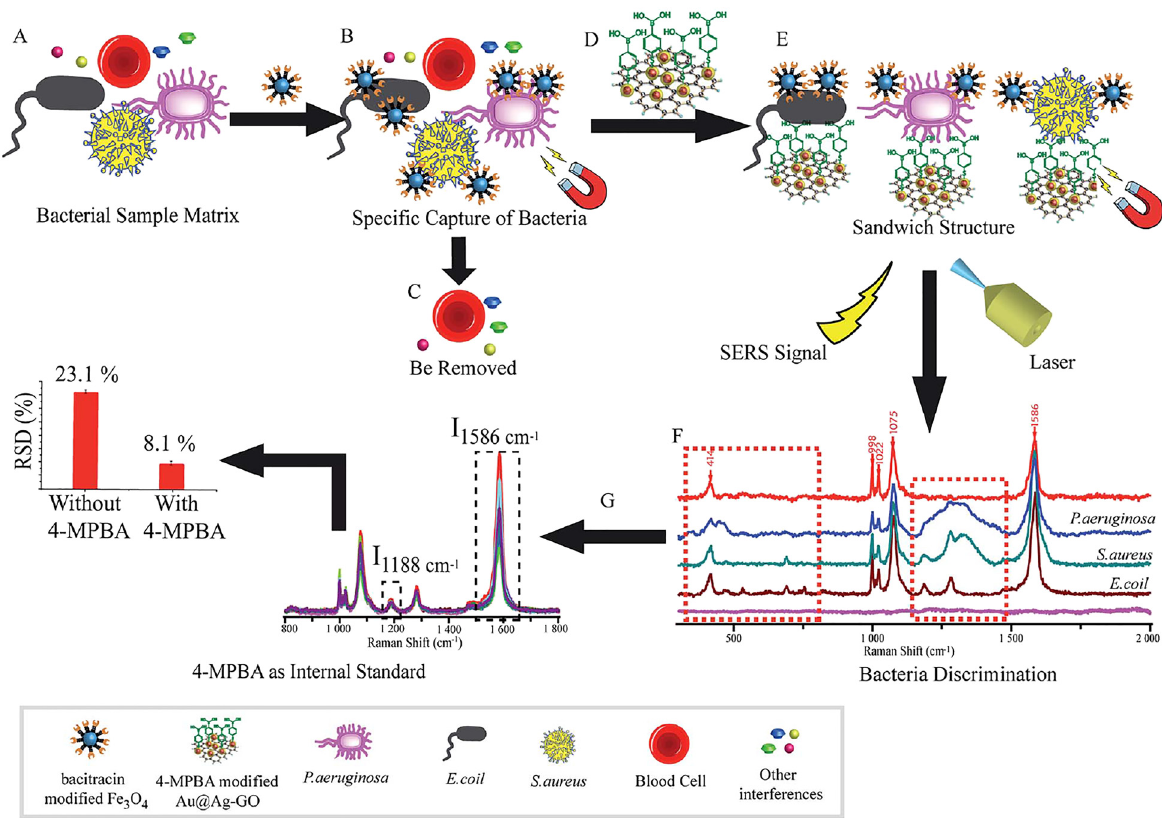
Figure 19: Schematic illustration of the operating procedures for bacterial detection via a surface enhanced Raman scattering (SERS) sandwich strategy, in which AMP modified magnetic Fe 3 O 4 NPs were utilized in the bacteria capture and 4-MPBA modi fi ed Au@Ag – GO nanocomposites were used as SERS